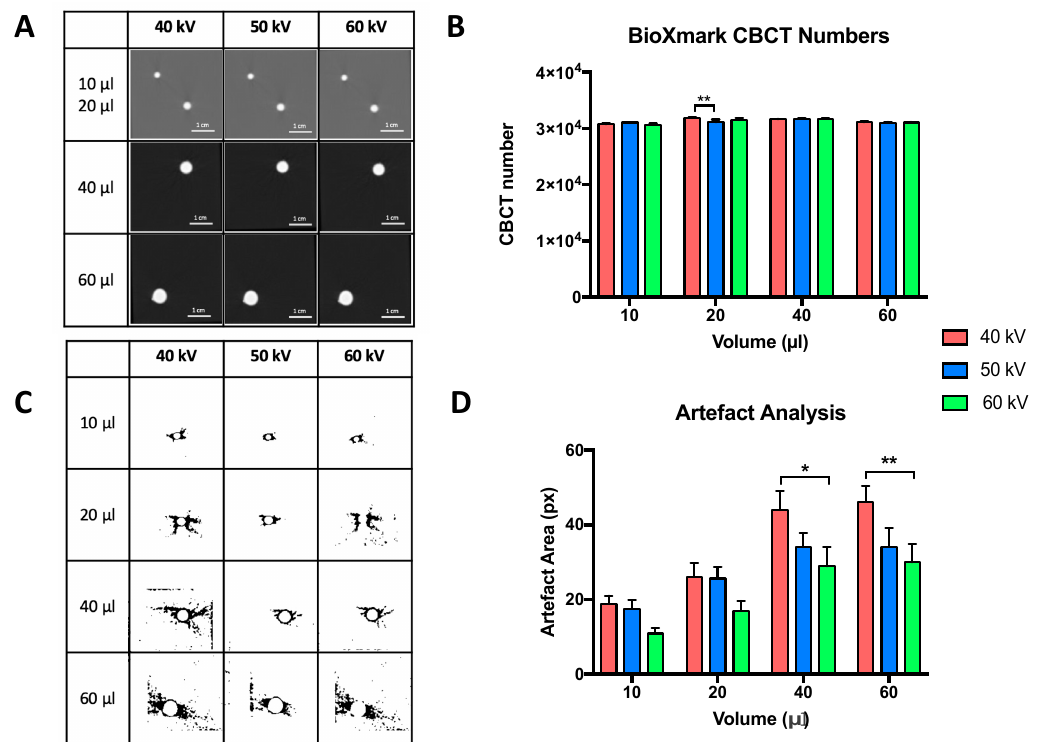
Figure 2. In phantom analysis of CBCT visibility and imaging artefacts for multiple volumes of BioXmark ® . ( A ) Representative imaging of 10, 20, 40 and 60 µL of BioXmark ® on CBCT at 40, 50 and 60 kV. CBCT scans were taken twice at each energy. Corresponding CBCT numbers at imaging energies of 40, 50 and 60 kV ( B ). Analysis of imaging artefacts were processed on ImageJ ( C ) and quantified ( D ). Data presented are mean values ± SEM; statistical significance is reported as * > 0.05, ** > 0.01.